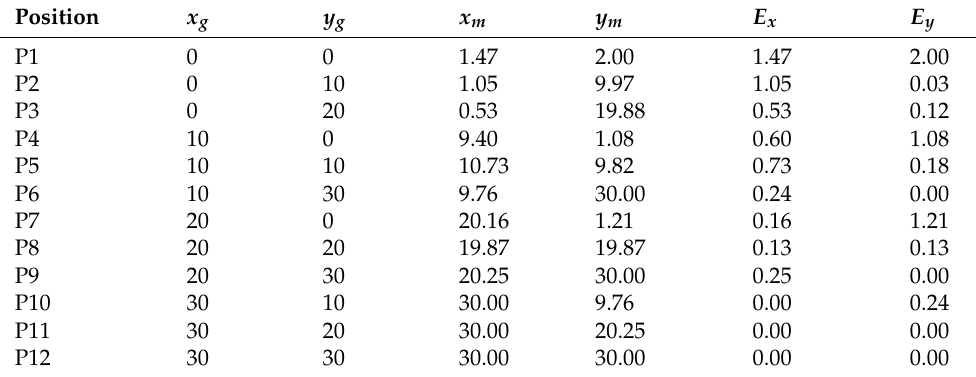
Table 8. Position estimation results obtained from Experiment B ( ◦